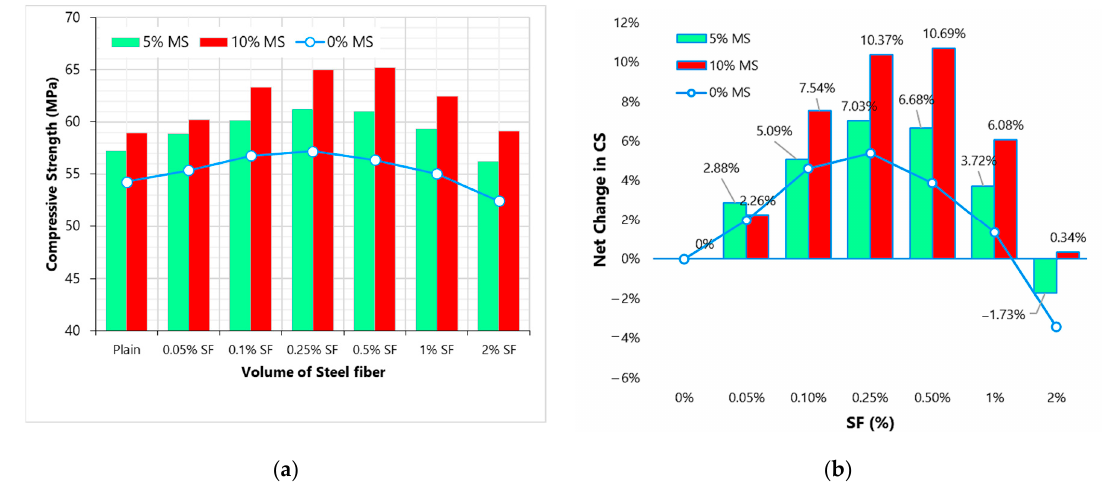
Figure 4. Compressive strength results ( a ) effect of MS on CS with varying SF dosage ( b ) effect of MS on the net change in CS with varying SF dosage.